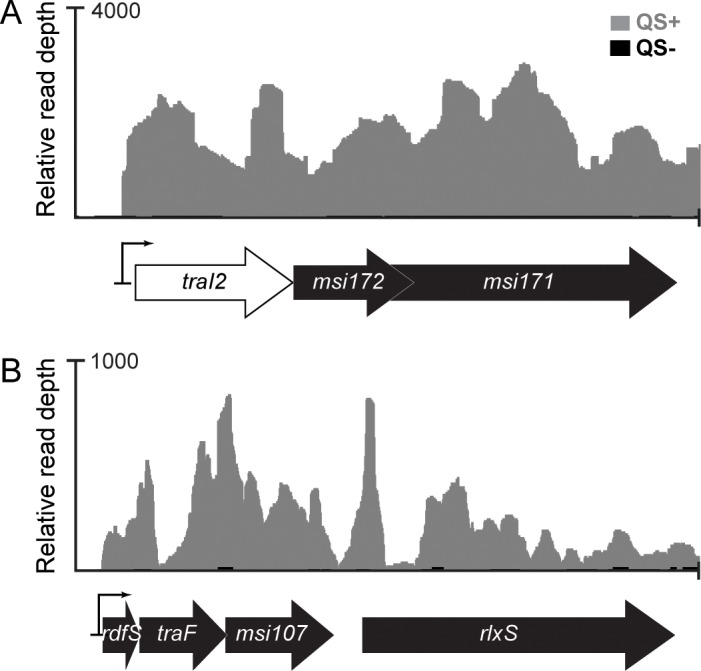
Quorum sensing activation of ICEMcSym1271 promoters.Overlayed relative read coverage (or sequencing depth) plots represent standardised values for the mean number of reads mapped to the positive strand of the regions shown in this figure from the three unfiltered QS+ (grey) and QS- (black) transcriptome libraries of WSM1271. QS+ strains were induced for QS by overexpressing both traI1 and traR1 from the plasmids pPR3-traI1 and pSDz-traR1, respectively, whereas the QS- control strains carried the parent vectors pPR3 and pSDz. The mean read depth for the (A) traI2-msi172-msi171, and (B) rdfS-traF-msi107 and rlxS regions of ICEMcSym1271 in QS- transcriptome libraries were almost non-existent relative to that of the QS+ strain (See S1 Dataset for a full list of TPM values from the filtered reads). A magnified view of reads mapping to the promoter region and the DNA sequence is shown in S4 Fig. These plots were produced using Integrated Genome Browser [73].